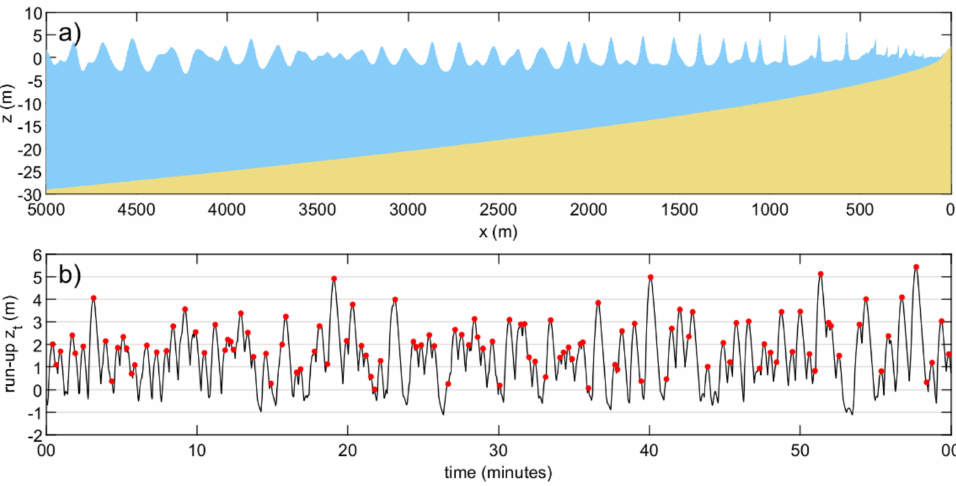
Figure 2. Snapshot of cross − shore wave evolution ( a ) and vertical run-up time series over 1 h ( b ) for H m 0 = 8 m, T p = 12 s, a D = 0.1, and tan β s = 0.1 zoomed in to first 5 km from the shoreline. Peaks in the vertical run-up signal ( b ) indicated by red